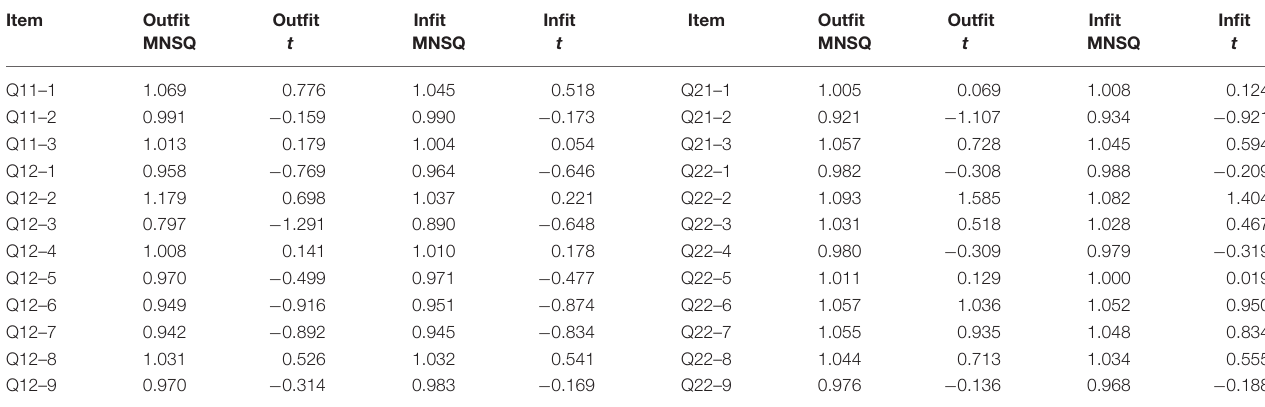
TABLE 3 | Item fit statistics in the Rasch